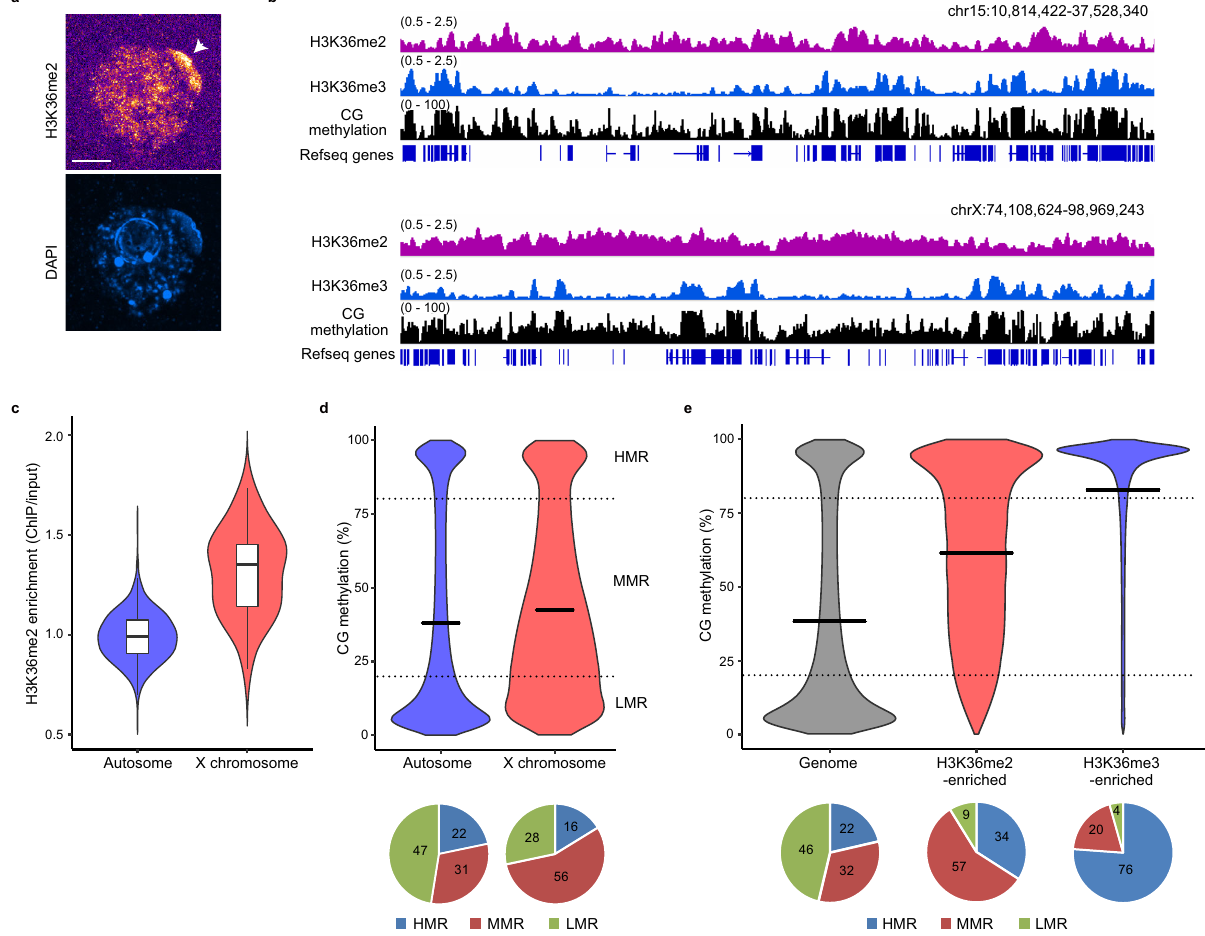
Fig. 1 | H3K36me2-enriched regions are associated with moderate levels ofCG methylation in FGOs. a Representative images of germinal vesicles of FGOs immunostainedforH3K36me2( n =14,fromtwoindependentexperiments).Other representative images are also shown in Supplementary Fig. 1a. An arrowhead indicates relatively strong H3K36me2 signals near the nuclear envelope. The maximum intensity projection images are shown. DAPI 4 ’ ,6-diamidino-2-pheny- lindol. Scale bar, 10 μ m. b Genome browser snapshots showing H3K36me2 and H3K36me3 enrichment and CG methylation in FGOs. The upper and lower panels show the representative regions of chromosomes 15 and X, respectively. H3K36me2 and H3K36me3 enrichment are indicated by ChIP/input. c Violin plots showing H3K36me2 enrichment in 5Mb bins in autosomes ( n =502) and X